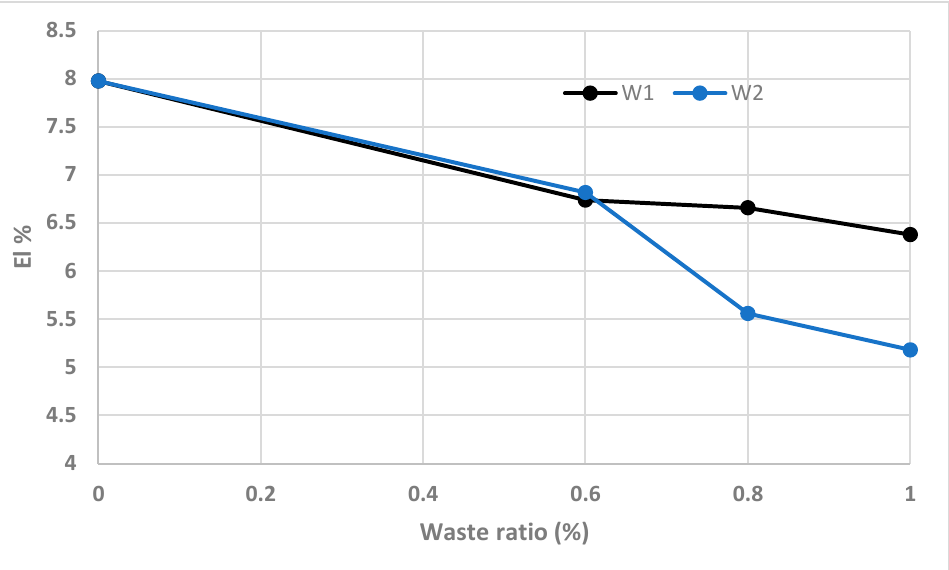
Figure 5. The effect of the proportion of waste fibre content on the elongation of blended yarns.